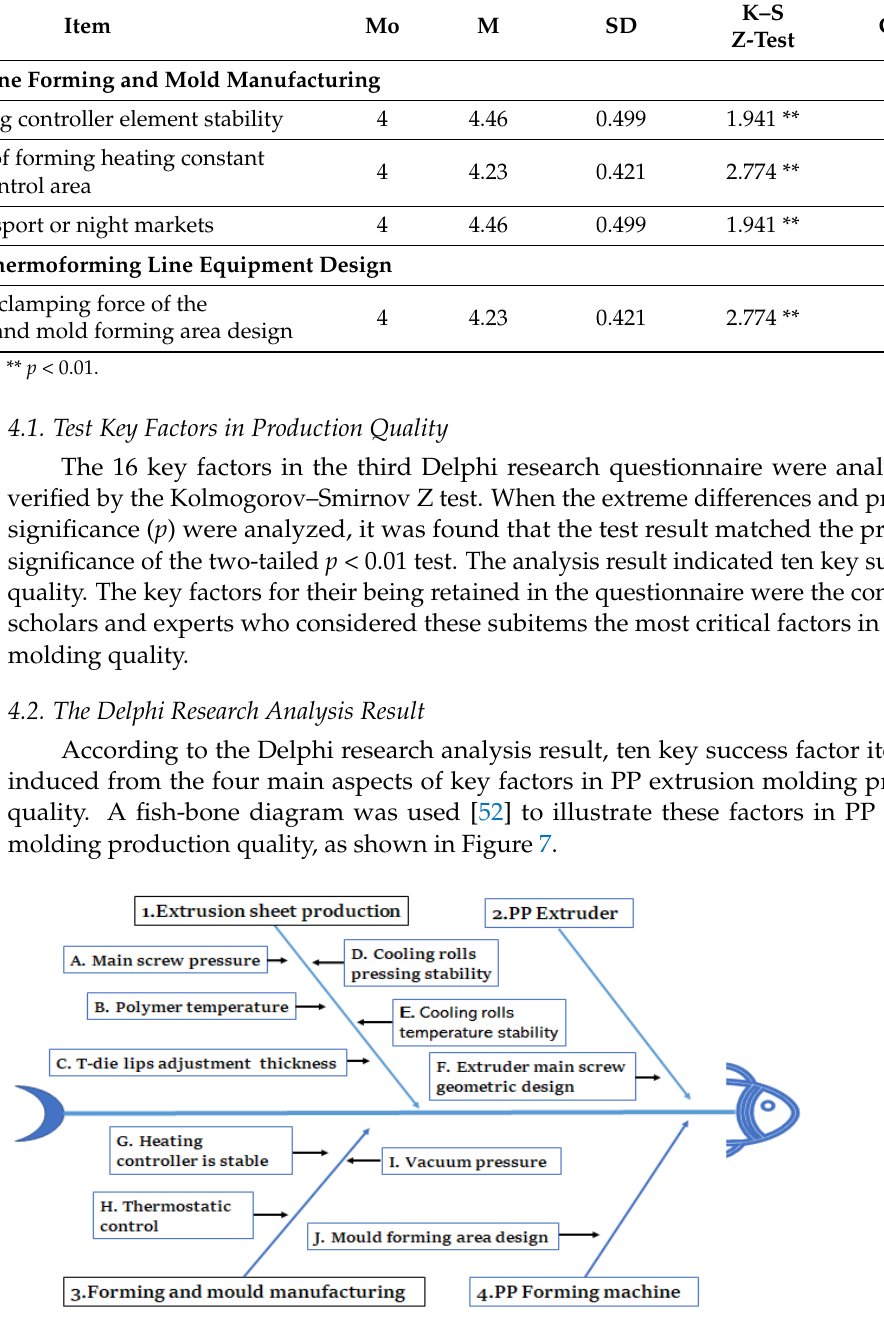
Figure 7. Important key factors affecting the quality of polypropylene extrusion